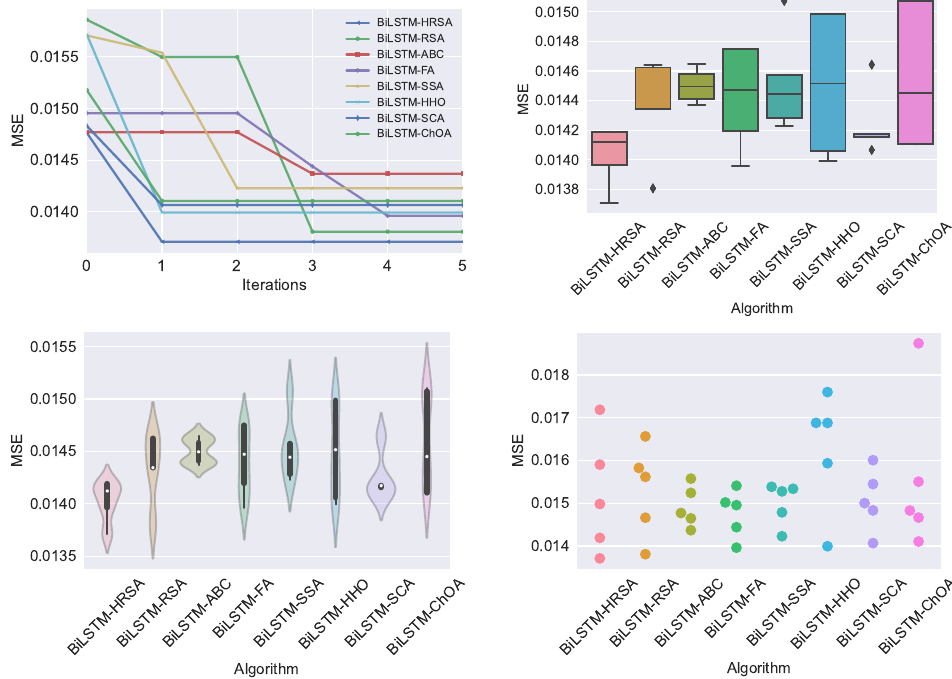
Figure 8. Visual BiLSTM simulations for each of 8 considered optimization methods with re- spect to the convergence, box plot, violin diagrams, and swarm diversity diagrams of the fitness function